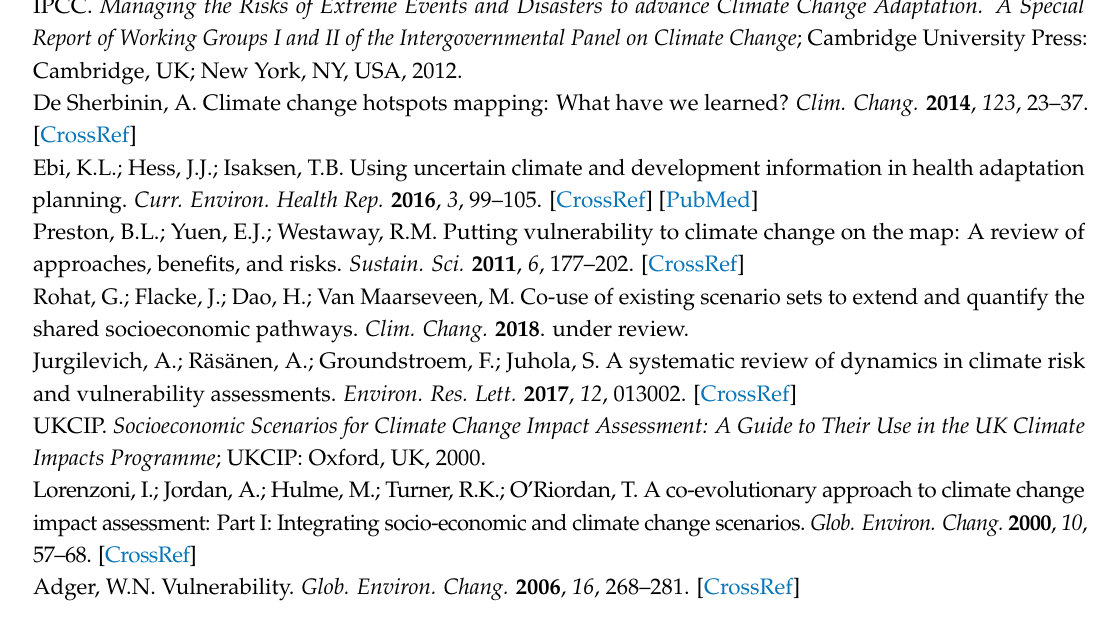
Table S1: Short narratives of the five Shared Socioeconomic Pathways; Figure S1: Questionnaire distributed to experts in overweight; Figure S2: Questionnaire distributed to experts in household composition; Figure S3: Experts’ level of agreement with the presented